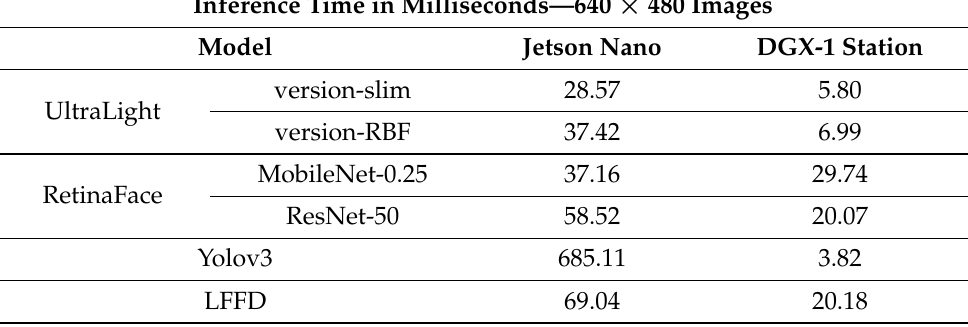
Table 7. Inference time for images with a resolution of 640 ×